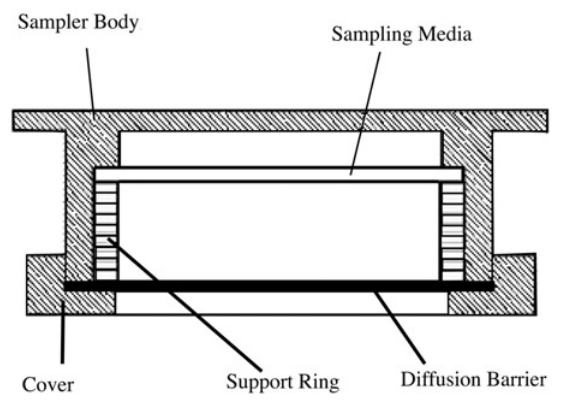
FIGURE 2. Rain shelter of Maxxam all-season passive sampling system with three passive samplers.